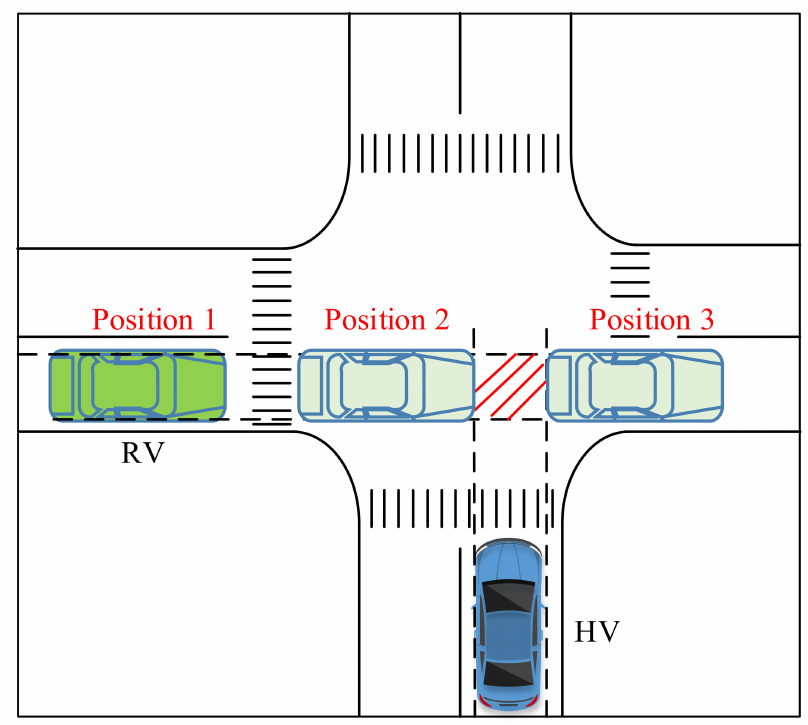
Figure 4. Schematic diagram of the limit position in the case of vehicle